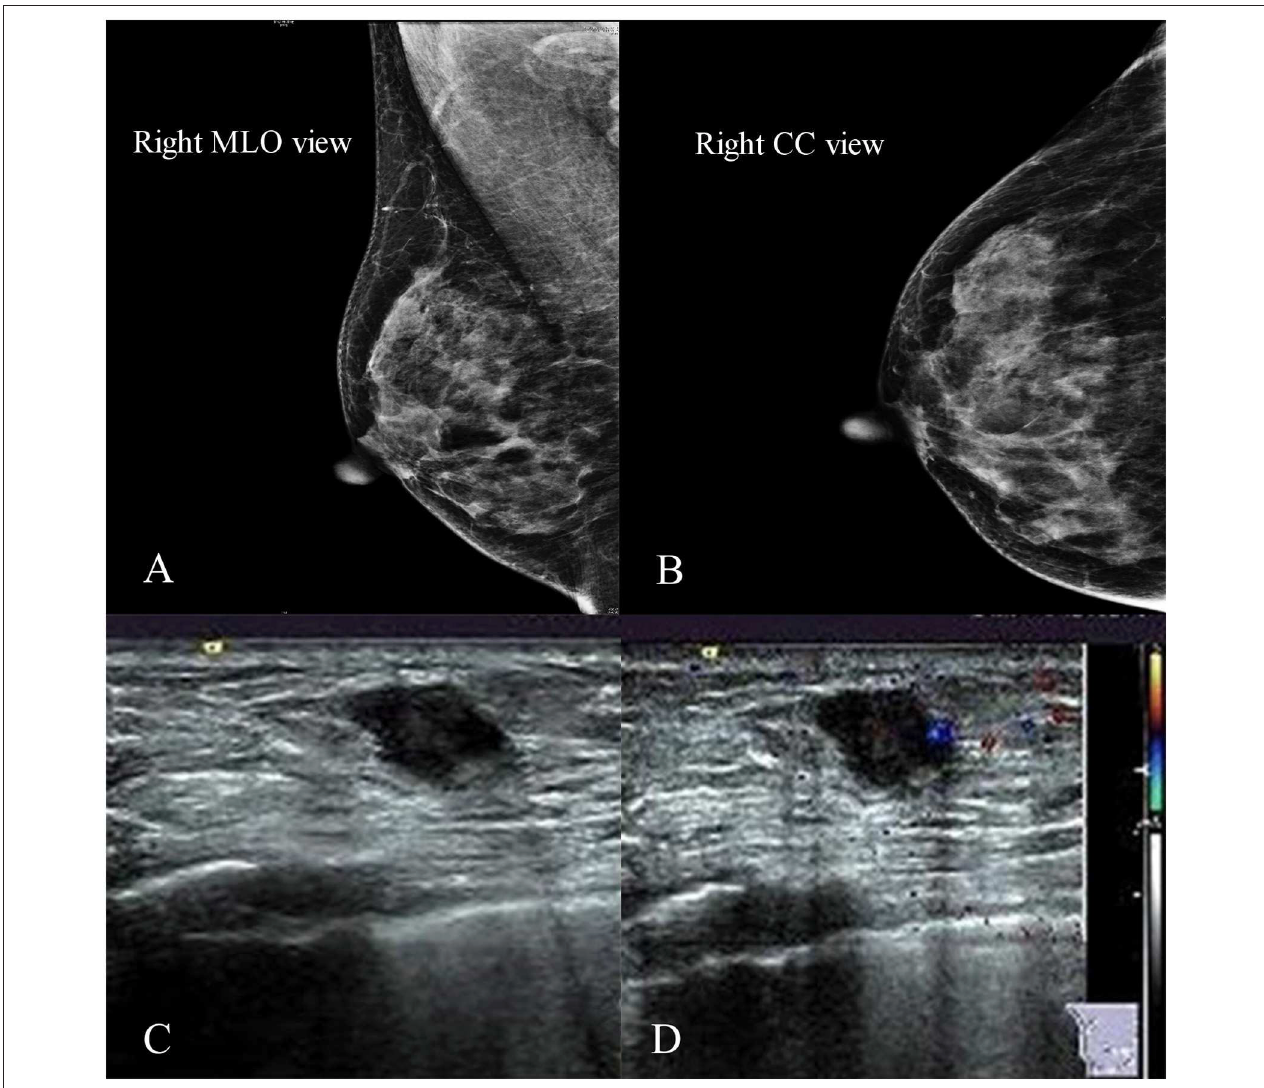
FIGURE 1 | Imaging of the primary tumor. (A,B) Right mammogram showed that the local structure of the inner quadrant of the right breast was crowding. (C,D) Ultrasound showed an irregular hypoechoic mass of 1.2 × 0.8cm located at 3–4